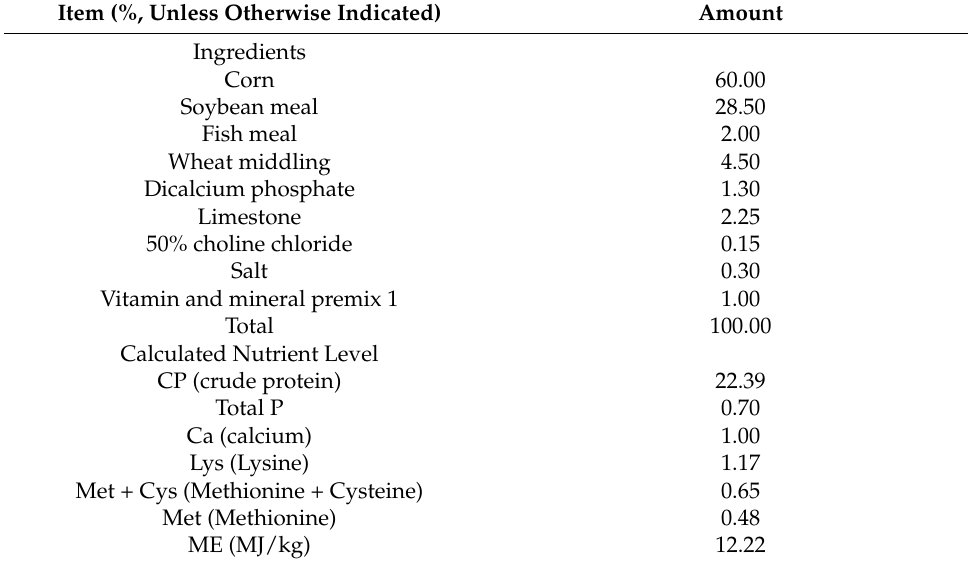
Table 1. Formulation and calculated composition of the basal diet (as-fed basis). Item (%, Unless Otherwise